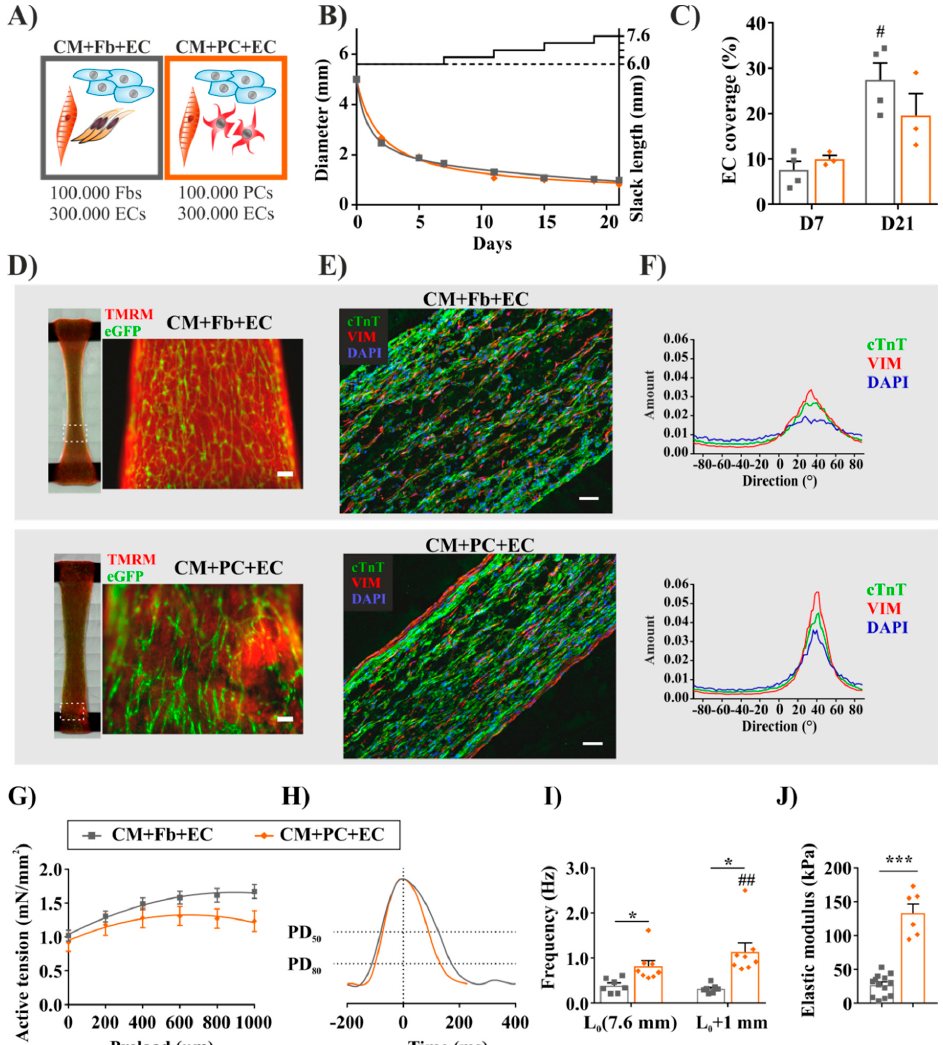
Figure 4. Fibrosis-related cardiac remodeling in a tri-culture model with ECs. ( A ) Cell compositions used for tissue preparation. All the BCTs contained 1 × 10 6 CMs, plus the indicated amount of other cell types. The different colors of the frames serve as legends for the other diagrams of the illustration. ( B ) Monitoring of tissue remodeling indicated by diameter change over time ( n = 3–4). ( C ) Development of EC networks during cultivation. EC coverage expressed as the percentage of surface area ( # p < 0.01 vs. D7). ( D ) Live imaging of the BCT morphology on D21. CMs are visualized by tetramethylrhodamin-methylester (TMRM, selectively labeling viable mitochondria-rich cells), ECs express endogenous eGFP (scale bar: 100 µm). ( E ) Immunofluorescent staining for cTnT and VIM to observe cell distribution, nuclei stained by DAPI (scale bar: 100 µm). ( F ) Directionality analysis of the tissues stained in sub-figure E. The Y-axis label “Amount” represents the proportion of structures with the dominant orientation. ( G ) Frank–Starling curves recorded on D21. ( H ) Representative spontaneous contractions normalized to peak height. PD—peak duration at 50% and 80% peak height. ( I ) Frequency of spontaneous contractions before and after force measurement at 0 and 1 mm preload ( ## p < 0.01 vs. L 0 ). ( J ) Calculated elastic modulus ( B and G – J : n = 6–12 BCTs per group, * p < 0.05 *** p < 0.001 between indicated groups).